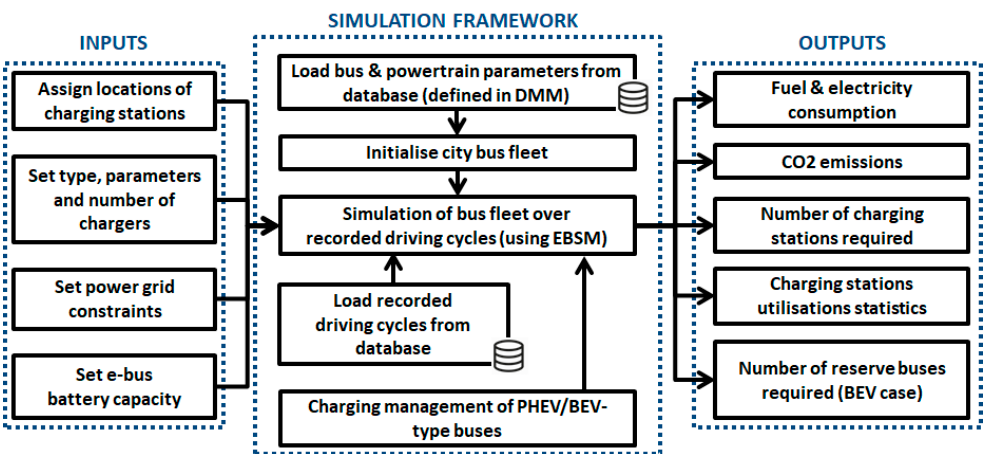
Figure 13. Flowchart of Charging Optimisation Module (COM) with embedded EBSM functionality.